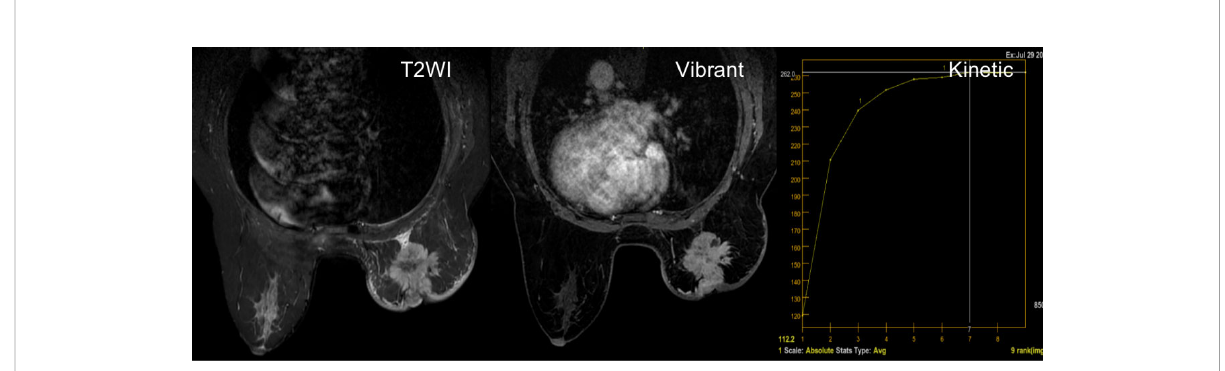
FIGURE 1 A 53-year-old woman diagnosed with invasive ductal carcinoma of the luminal B subtype. The T2-weighted image shows a strong hyperintense signal inside the mass without enhancement on subtracted images, representing necrosis. The Vibrant technology shows an irregular mass with an irregular margin and a heterogeneous enhancement. Kinetic curves generated from two regions of the enhanced ring demonstrate a plateau appearance (type II